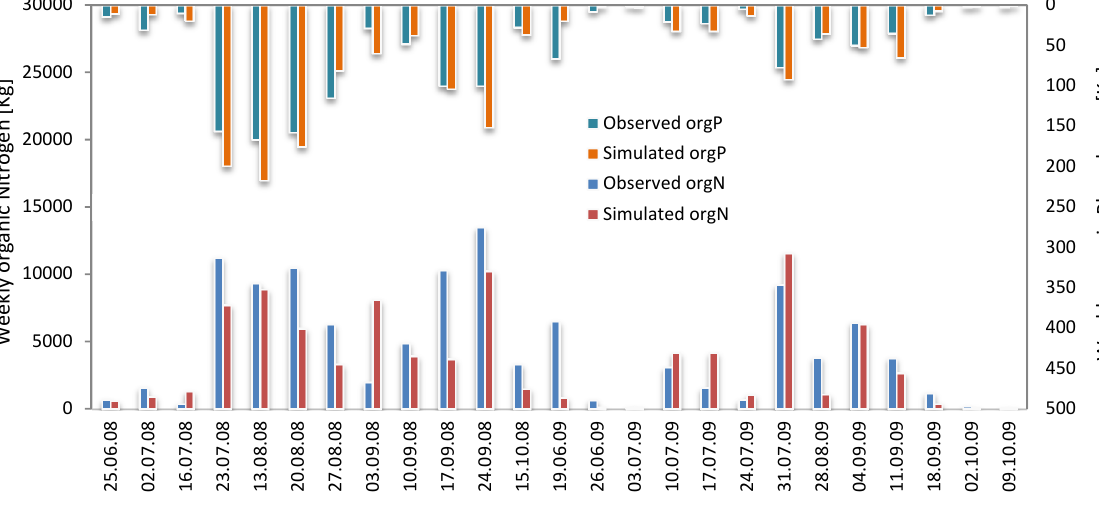
Figure 6. Simulated vs. observed weekly organic N and P load for the Atchérigbé sub-catchment (6978 km 2 ). Only validation was performed from 2008 to 2009 with R 2 = 0.58 and ME = 0.78 for organic Nitrogen and R 2 = 0.89 and ME = 0.96 for organic